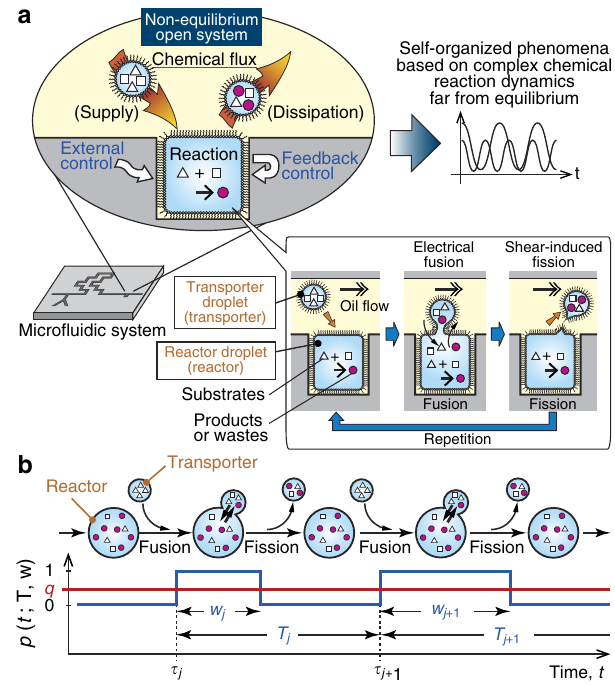
Figure 1 | Schematic diagram of chemical reactions far from equilibrium in a droplet open-reactor system controlled by pulse-density modulation. ( a ) In the droplet open-reactor system, the supply of substrates and the dissipation of products/wastes into/out of the reaction system are sustained, inducing self-organized phenomena based on complex chemical reaction dynamics far from equilibrium. The chemical reactions in the droplet open-reactor system are dynamically varied based on external control and feedback control. The droplet open-reactor system is based on the repeated fusion and fission of droplets. ( b ) A fusion–fission process and the pulse-density modulation concept. T j and w j are the interval and duration of j -th fusion–fission event, respectively. p ( t ; T , w ) is a square pulse-train function used to express a fusion–fission process ( T ¼ { T j }; w ¼ { w j }). q is the basal strength of the chemical fluxes. t j is the time at which the j -th fusion